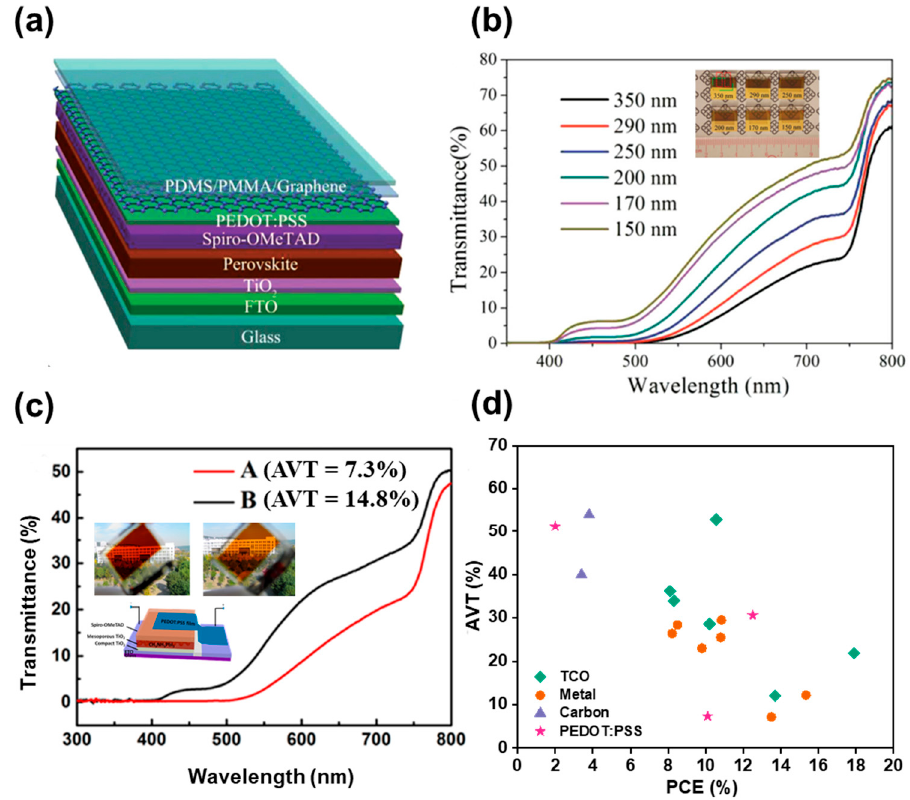
Figure 4. ( a ) Schematic representation of fabricated ST-PSC with graphene as the top electrode. ( b ) Transmi tt ance spectra for the corresponding devices with di ff erent thicknesses (Inset: Digital images of cells prepared with di ff erent thicknesses). ( c ) Transmi tt ance spectra for cells with di ff erent thicknesses (Inset: Schematics of device using PEDOT:PSS and digital images of fi lms with di ff erent transparencies). ( d ) Interrelation between PCE and AVT for various electrodes used in ST-PSCs: TCO [64,66,67,112,113]; Metal [40,41,74,114–117]; Carbon [118,119]; PEDOT:PSS [109,111,120]. Reprinted with permission from Refs. [97,109].